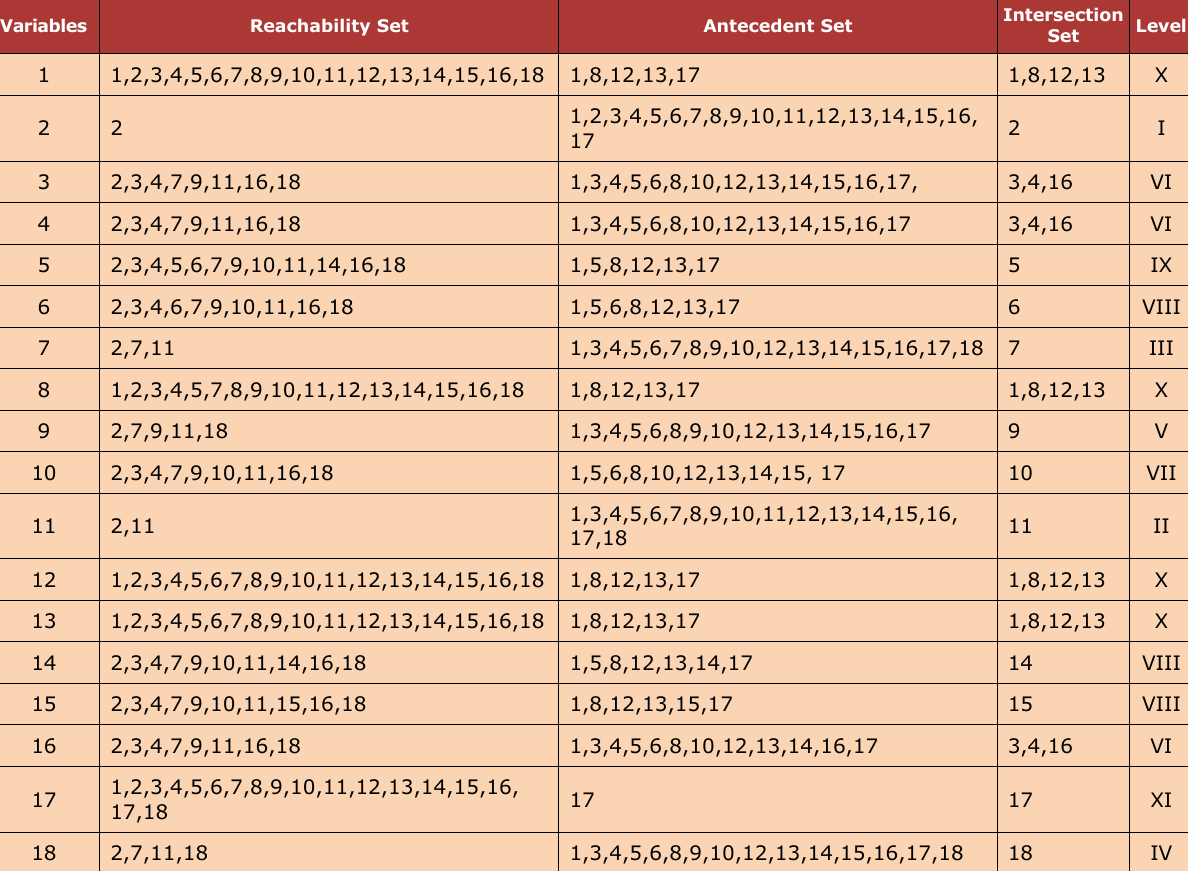
Table 8. Partitioning of Variables-Iteration